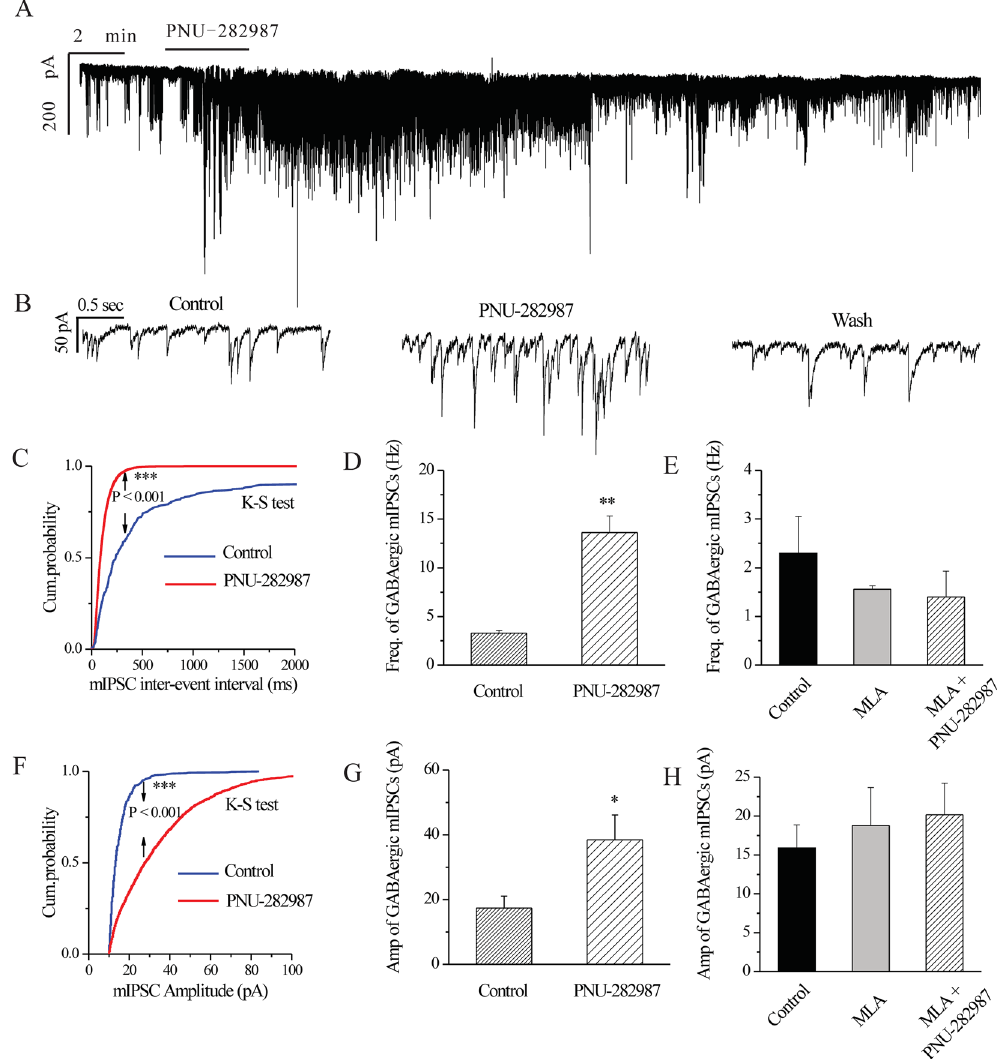
Figure 7. PNU-282987, a selective α 7-nAChR agonist, increases the frequency and amplitude of mIPSCs in control rat RGCs. ( A ) Voltage clamp recording (at − 70 mV) of a representative normalized RGC shows that PNU-282987 increases the frequency and amplitude of GABAergic mIPSCs in RGCs. Vertical bar, 200 pA; horizontal bar, 2 min. ( B ) The recording of the RGC on an expanded scale in time, vertical calibration bar, 50 pA; horizontal calibration bar, 0.5 s. ( C,F ) Cumulative inter-event interval and amplitude distributions of the mIPSCs of a representative RGC before and during PNU-282987 application. PNU-282987 causes a leftward shift in the inter-event interval ( C ) and a rightward shift in the amplitude ( F ) distribution curves, indicating that PNU-282987 significantly increases mIPSC frequency and amplitude ( n = 9). *** p < 0.001 (Kolmogorov – Smirnov test). ( D,G ) Quantification of the frequency ( D ) and amplitude ( G ) of the mIPSCs ( n = 5). ( E,H ) Pre- incubation with MLA (1 μ M), a selective α 7-nAChR antagonist, inhibits the effects of PNU-282987 (10 μ M) on the frequency ( E ) and amplitude ( H ) of mIPSCs ( n = 3). Administration of MLA alone does not affect the baseline frequency ( E ) or amplitude ( H ) of the mIPSCs. * p < 0.05, ** p < 0.01 (Student’s paired t test). The results in D , E , G , and H are expressed as the mean ±